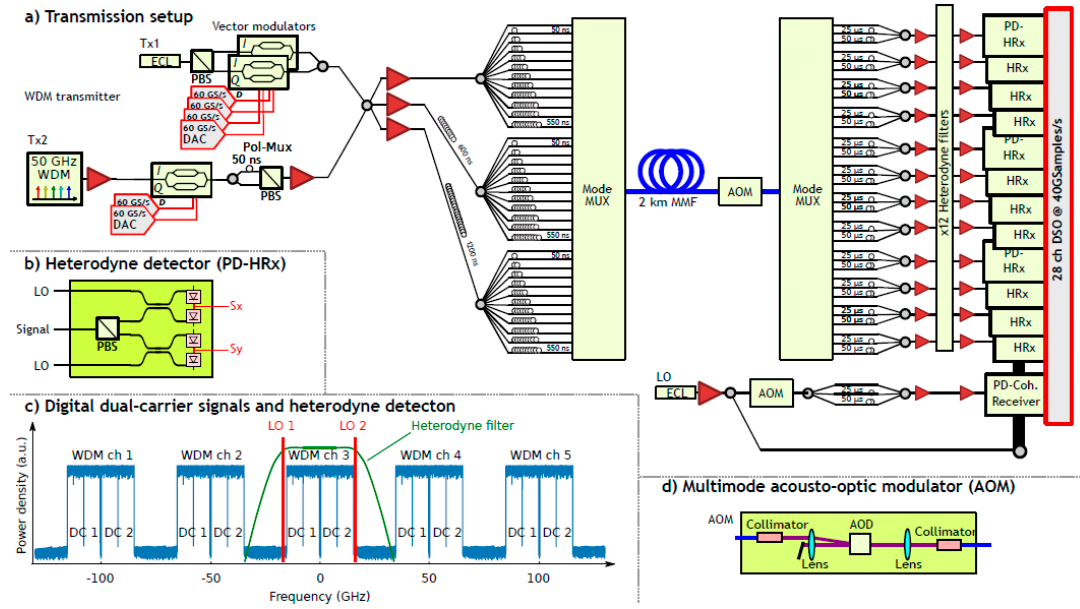
Figure 32. ( a ) Setup of a 72 × 72 MIMO-based transmission; ( b ) heterodyne receiver arrangement; ( c ) spectrum of the test signal and location of the heterodyne filters and local oscillator; ( d ) multimode acousto-optic modulator [46].